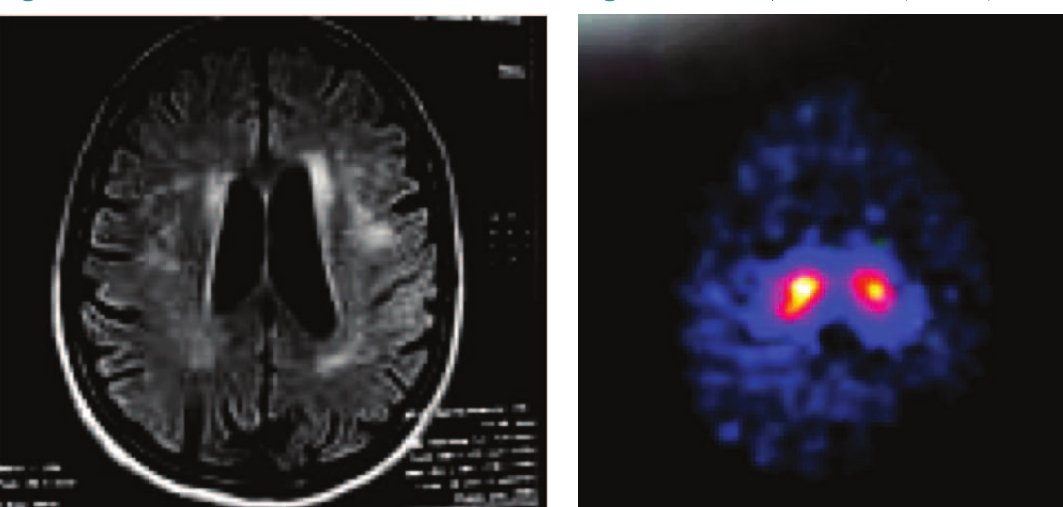
Figure 3. I123 Iofl upane CIT SPECT